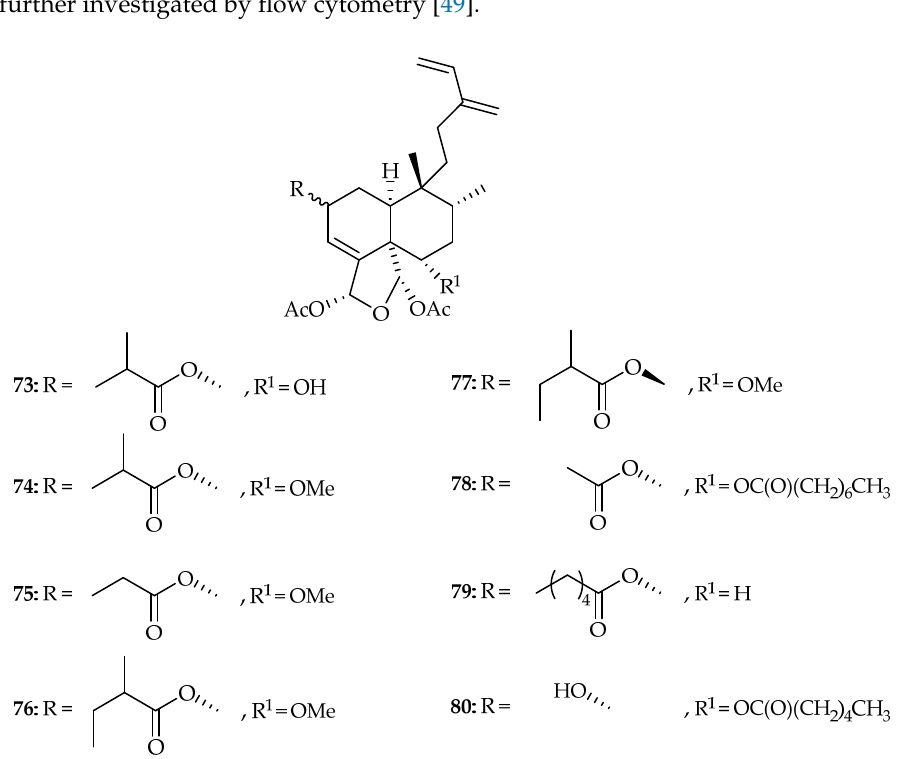
Figure 31. Structures of corymbulosins I, K, L, N, O, P, T, and V 73–80 [49]. A new clerodane furano diterpene glycoside TC-2 81 was isolated from the aqueous alcoholic extract of Tinospora cordifolia (Menispermaceae) stems (Figure 32). The structure of TC-2 81 was determined on the basis of spectroscopic data interpretation and confirmed by a single-crystal X-ray crystallographic analysis of its corresponding acetate. The in vitro anti-cancer activity of TC-2 81 was evaluated, and it showed cytotoxic activity, with an IC 50 value of 8 μM against the HCT-116 cell line, using 5-FU as a positive control, 10.4 μM against the prostate cancer cell line (PC-3), using mitomycin-C as a positive control, and 14.8 μM against the melanoma cancer cell line (MDA-MB-435). It was demonstrated that the new clerodane diterpenoid 81 induced apoptosis of HCT-116 cells mainly by trigger- ing ROS (reactive oxygen species) production [50]. Figure 32. Structure of TC-2 81 [50]. 3.1.2. Halimane-Type Diterpenoids The halimane skeleton derives from a methyl migration of the labdane skeleton and is present within a diverse number of species of the plant, animal, and bacteria kingdoms.